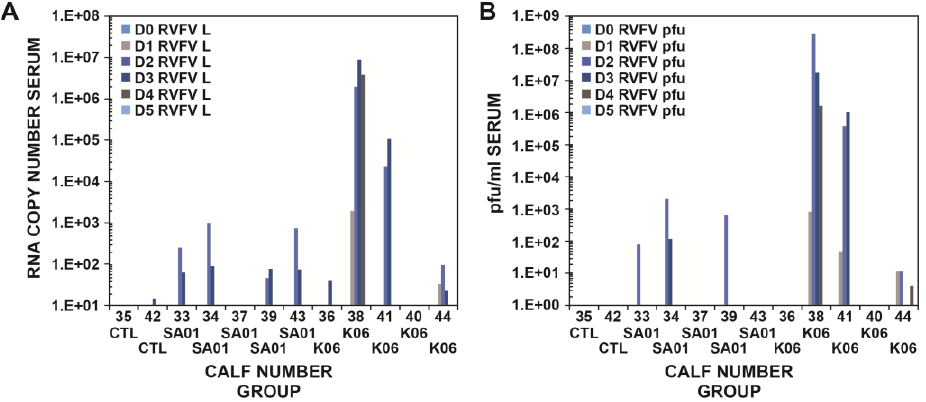
Figure 2. Viral replication dynamics in individual calf serum as determined by molecular and traditional virological methods. ( A ) Quantitative real-time RT-PCR-determined RVFV L segment copy number per reaction calculated from the mean Ct for the RVFV L segment from Day 0–Day 5